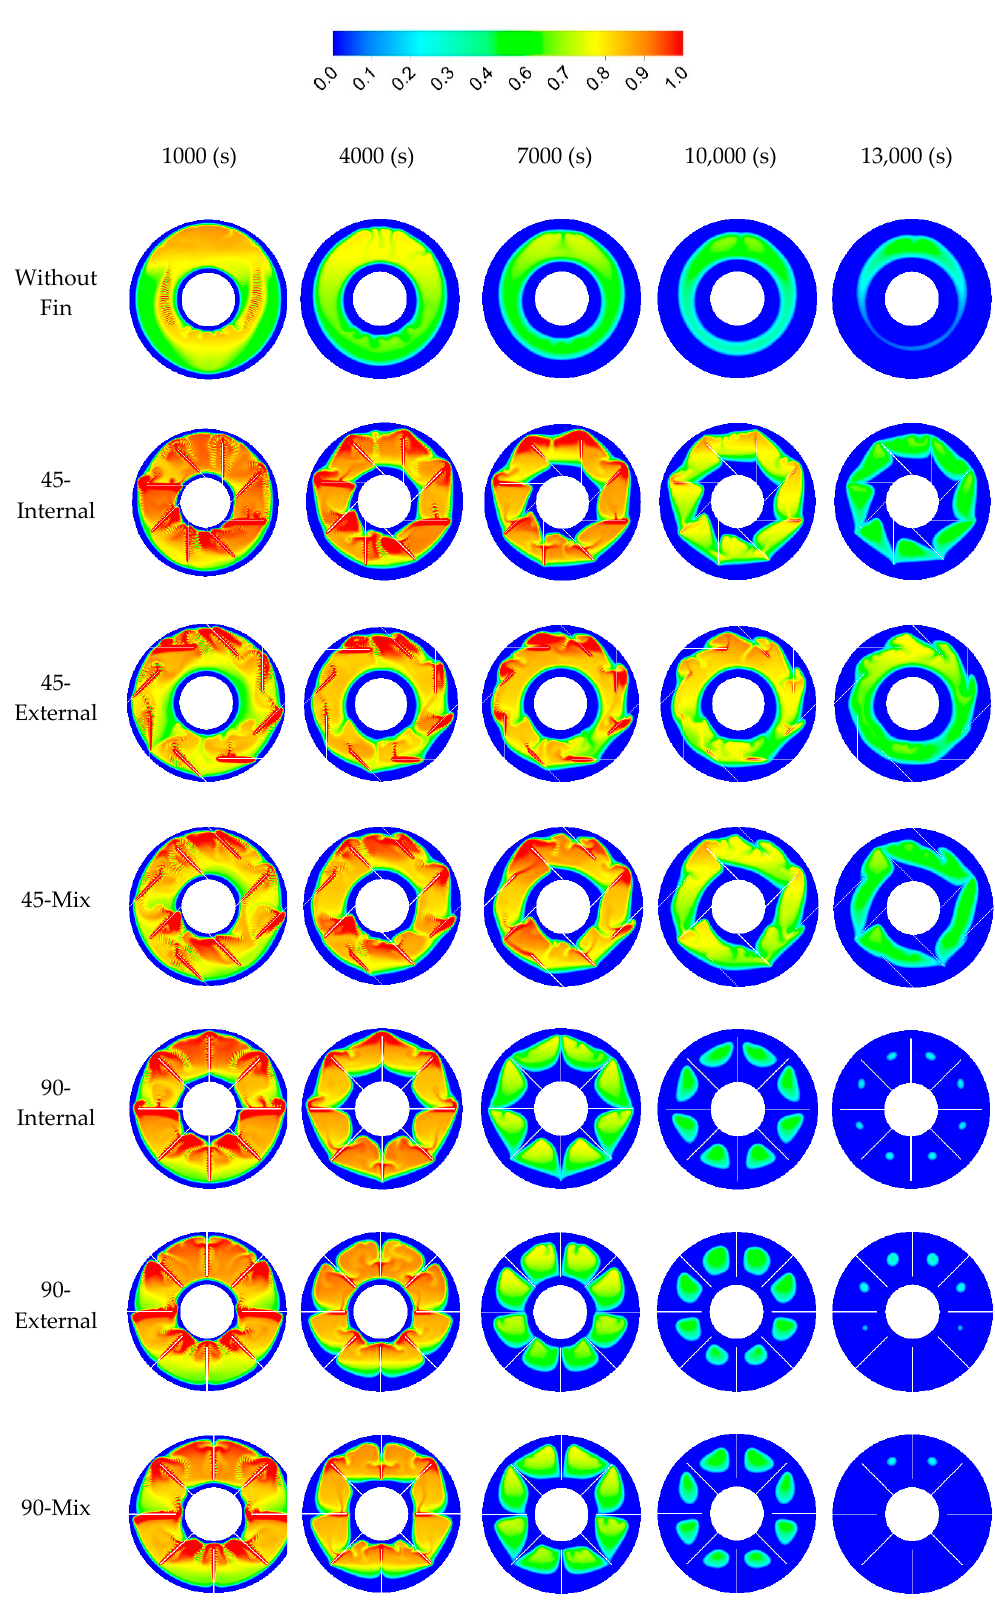
Figure 5. The liquid fraction contours for PCM area with di ff erent fins configurations with the same dimensions (1 mm × 42